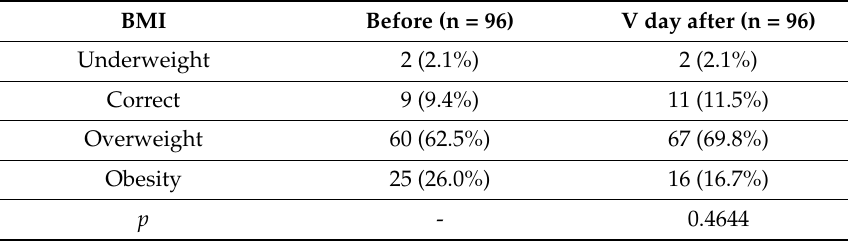
p —statistical value, BMI—body mass